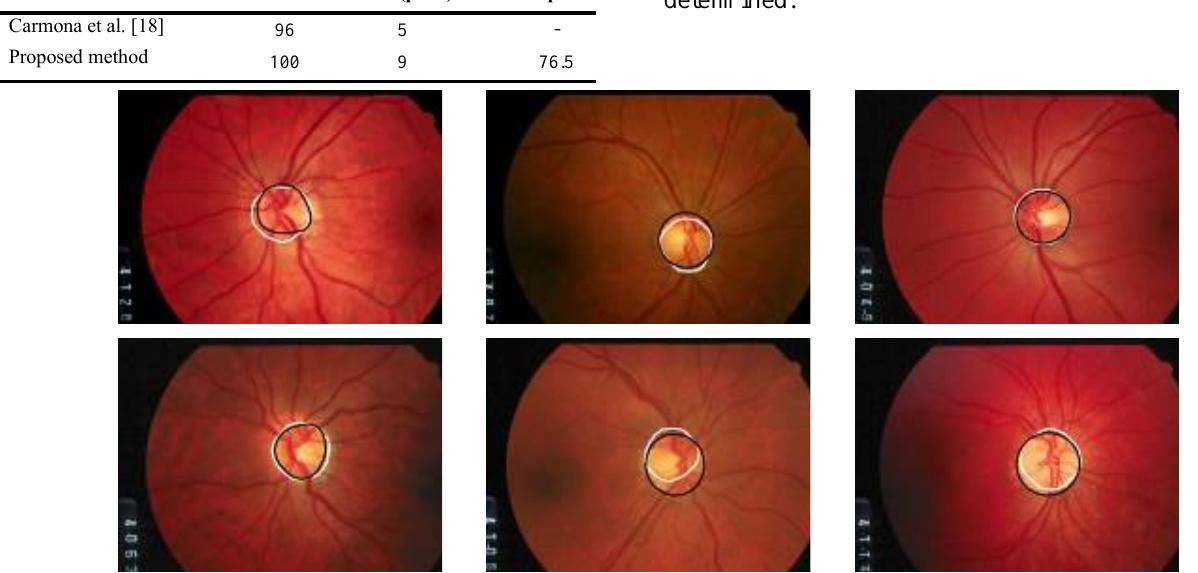
Figure 9. Results obtained for proposed method on DRIONS dataset images. Detected boundary of optic disc is shown by white curve, and ground truth is shown by black curve.